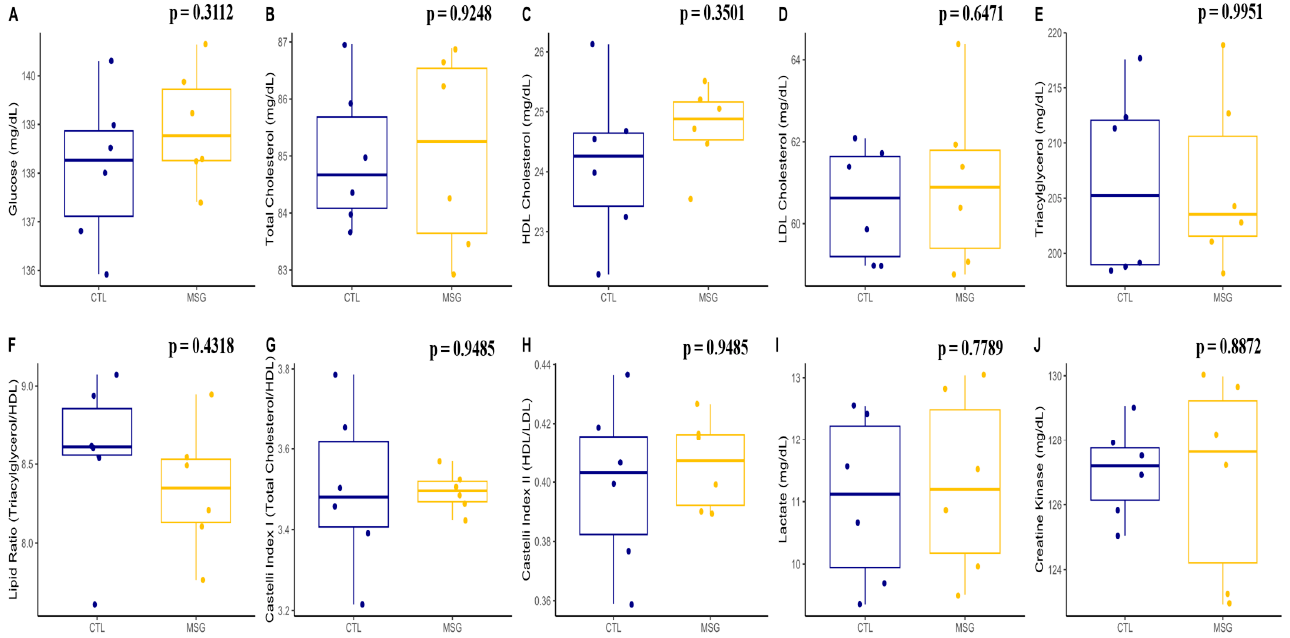
Figure 5. Graphs related to plasmatic profile in PND15: ( A ): glucose (mg/dL); ( B ): total cholesterol (mg/dL); ( C ): HDL cholesterol (mg/dL); ( D ): LDL cholesterol (mg/dL); ( E ): total triacylglycerols (mg/dL); ( F ): lipid ratio (total triacylglycerols/HDL); ( G ): Castelli index I (Total Cholesterol/HDL); ( H ): Castelli index II (HDL/LDL); ( I ): lactate (mg/dL); ( J ): creatine kinase (mg/dL). The CTL is rep- resented in blue and the MSG group is represented in yellow.